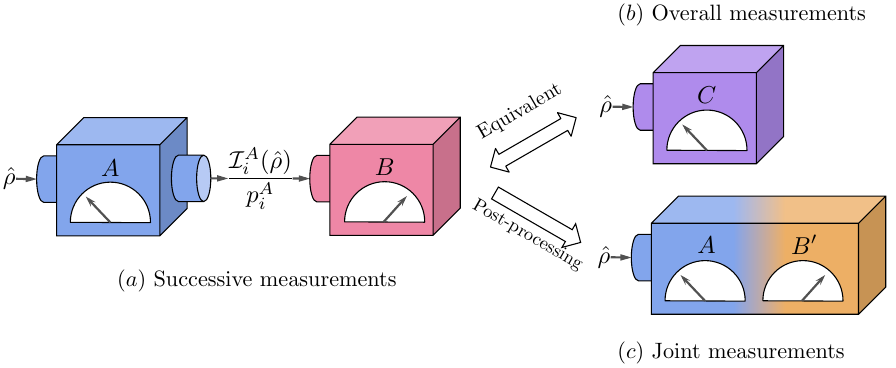
Figure 1. Relations among measurement schemes. ( a ) Successive measurement of observables A and B , where the first measurement A gives rise to output state ( b ) Overall measurement of C obtained by performing the successive measurement of A and B ; ( c ) Joint measurements obtained in successive measurement scheme by considering the marginal